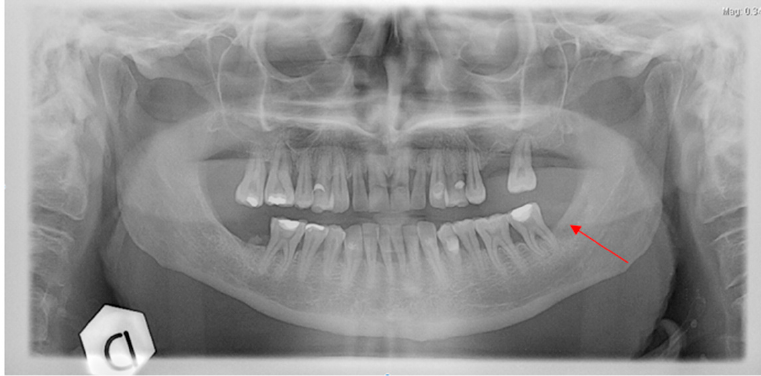
Figure 5. Case 2: Rx orthopatogram of the post ‐ extractive socket.